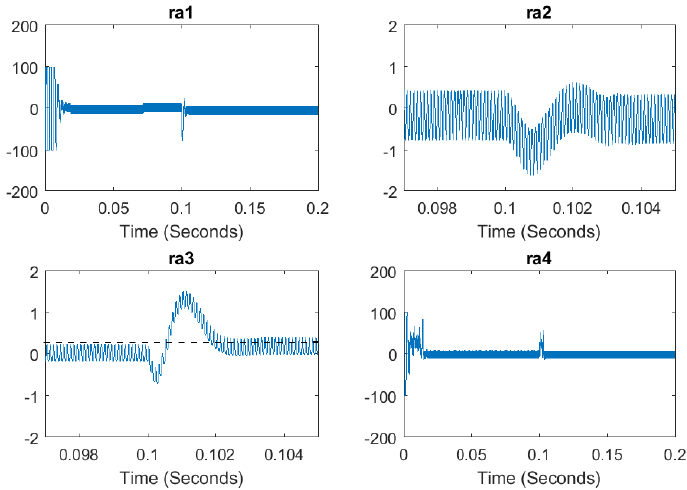
Figure 18. Simulation of residuals in the case of an output capacitor C